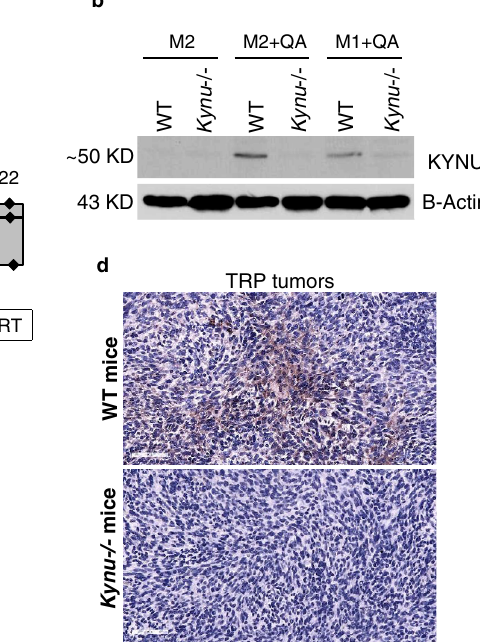
biologically independent experiments. c , d TRP tumorswere grown orthotopically in C57BL/6NJ WT ( n =8; gray) or Kynu -/- ( n =6; red) mice and QA levels was determined by ( c ) ELISA and ( d ) immunohistochemical staining. All samples were biologicallyindependent.Linebetweendatapointsrepresents mean,and whiskers represent SE ( c ). Statistics: Two-tailed Student ’ s t -test ( a and c ). All tests were performed at 95% con fi dence interval. Source data are provided as a source data fi